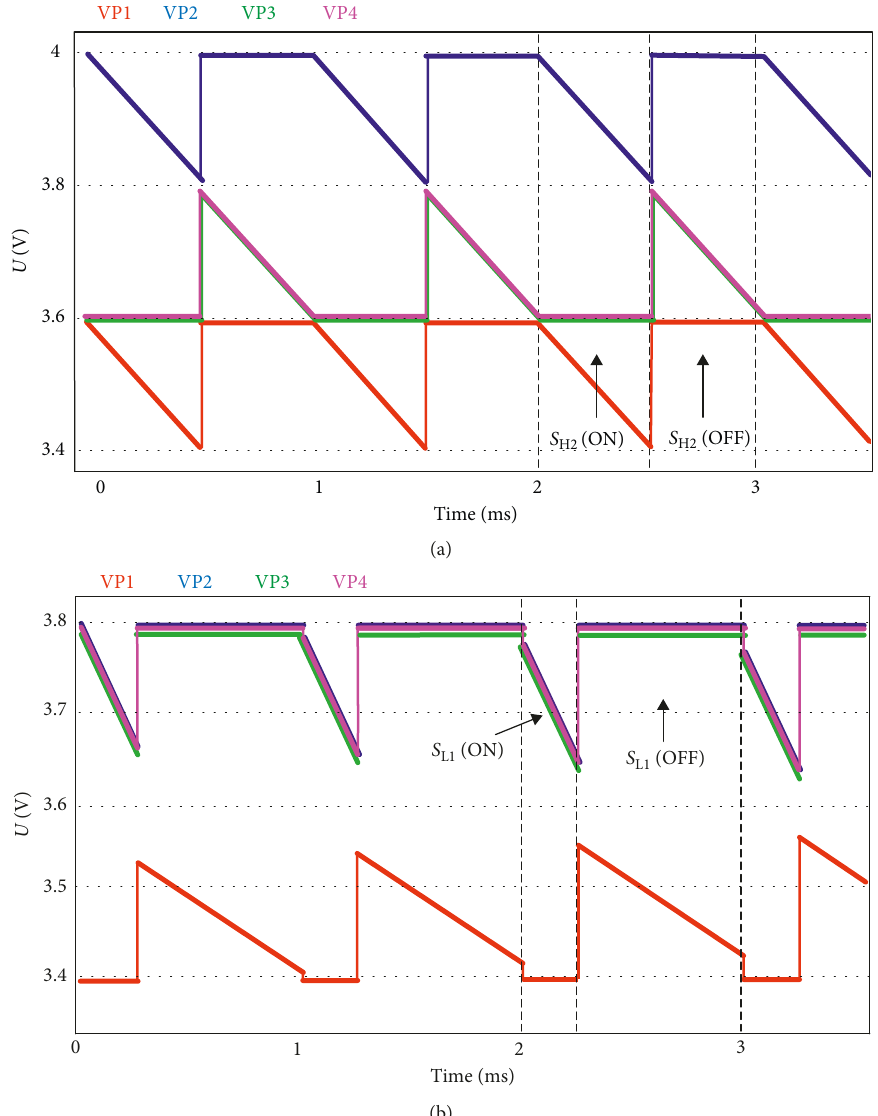
Figure 6: Waveforms for four battery cells energy equalization. (a) Battery voltage in mode I and mode II and (b) battery voltage in mode III and mode